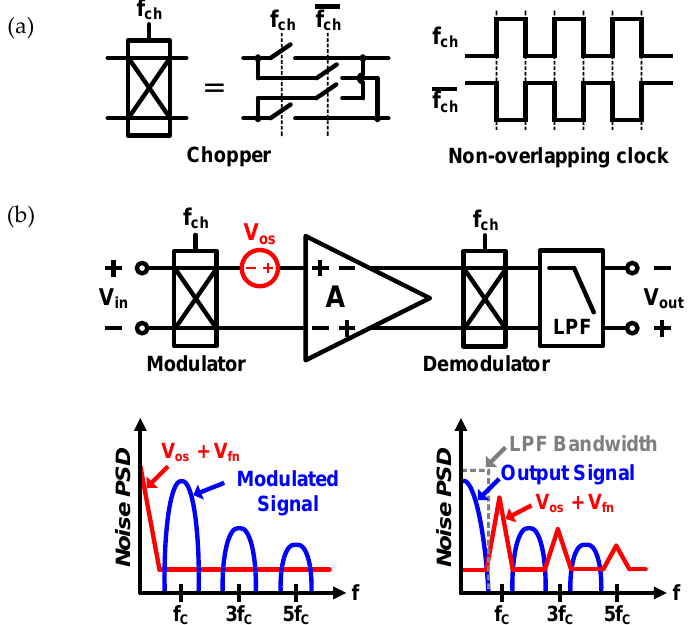
Figure 4. ( a ) Chopper and driving clock and ( b ) chopping technique.